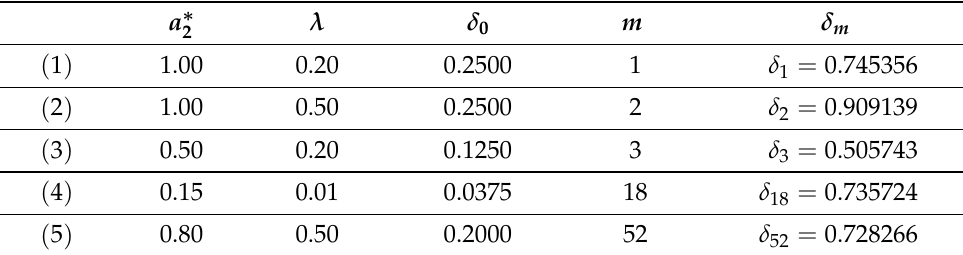
Table 1. The first value of δ m which satisfies Condition